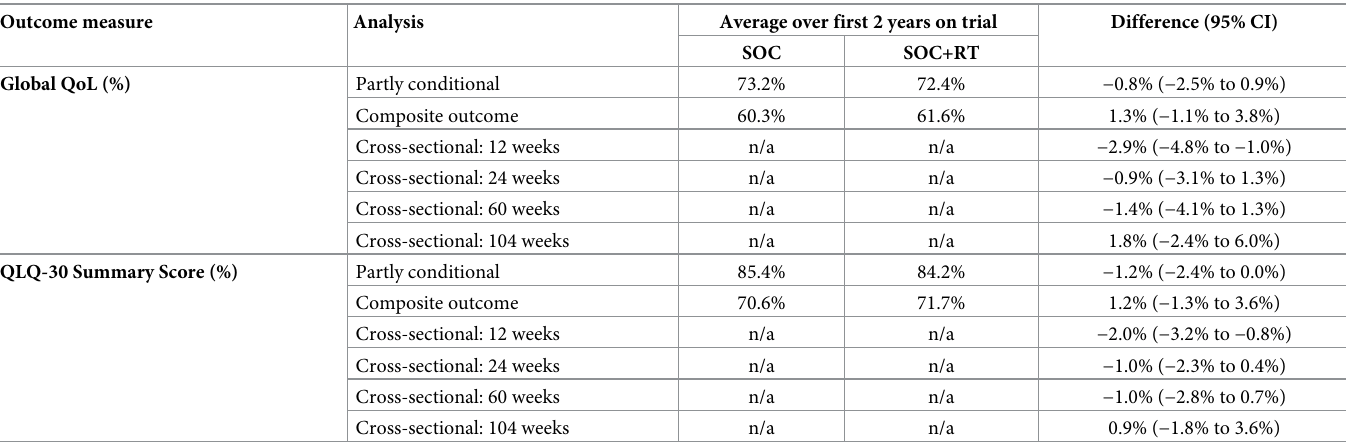
Table 5. Summary of QoL